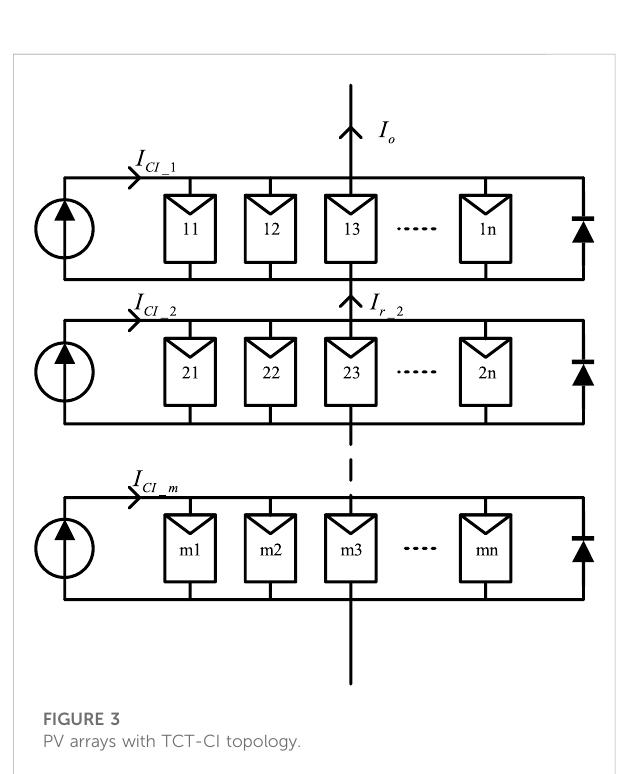
FIGURE 3 PV arrays with TCT-CI topology.